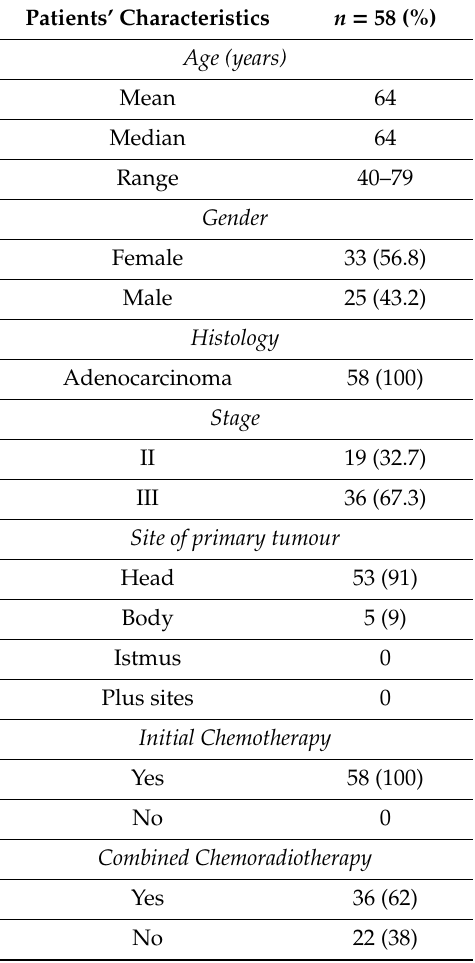
Table 1. Patients’